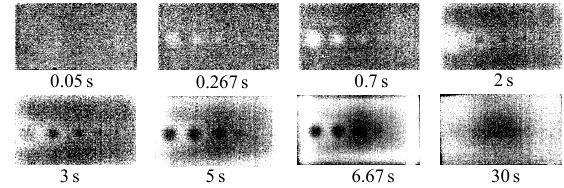
Fig. 14 Thermal images sequence of the specimen 2# after differential processing.